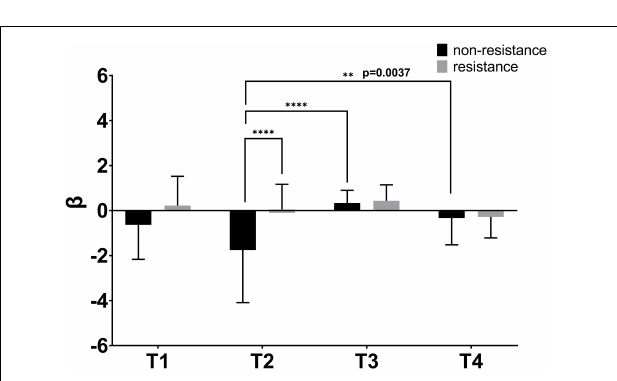
FIGURE 7 | β values of four trajectories under two movement modes. The abscissa shows four trajectories. The coordinate is the value of β . β was extracted from the general linear analysis model (GLM). The bar indicates the errors. ∗∗ p < 0.01, ∗∗∗∗ p <